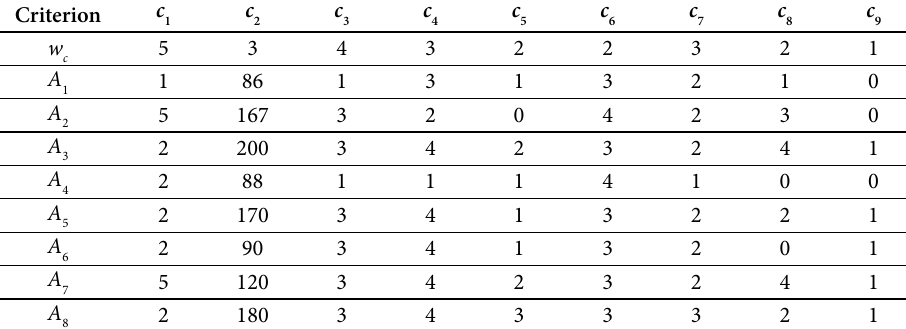
Table 2. Rough evaluation